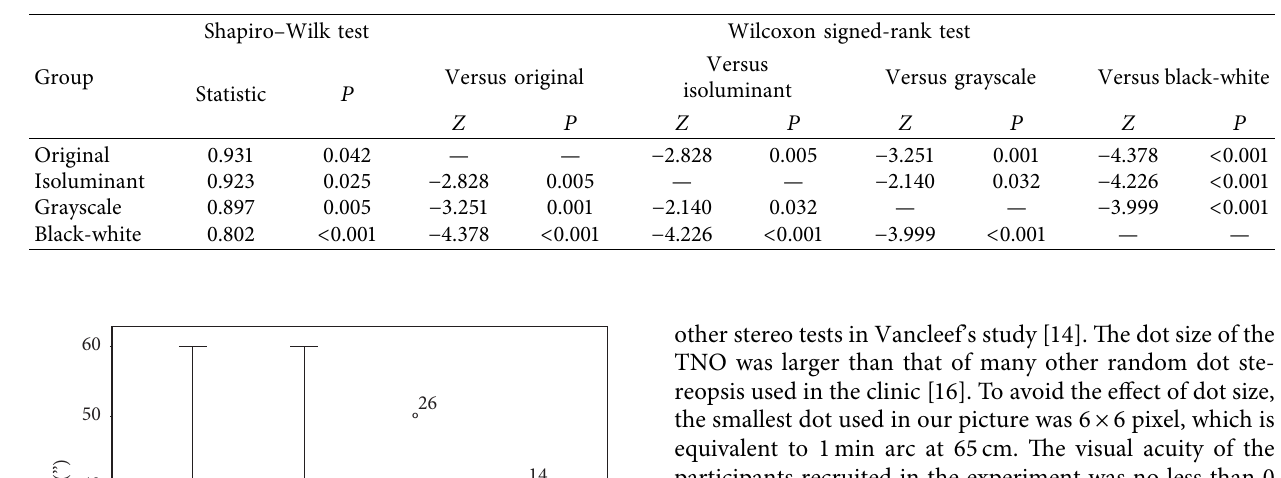
Table 2: Statistical result of the data.